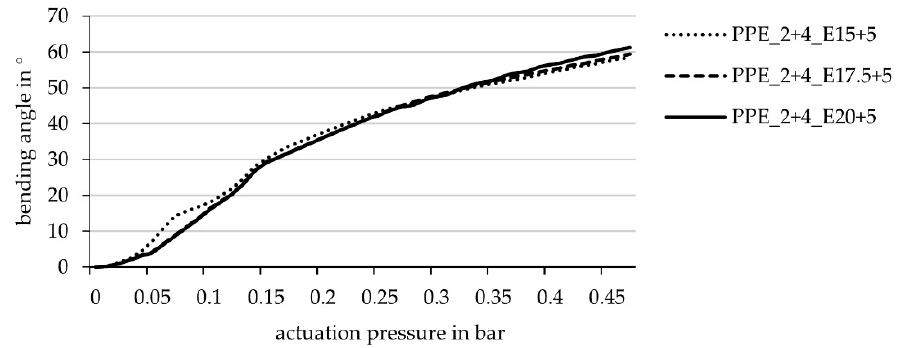
Figure 12. Achievable bending angle (simulation) in relation to the actuation pressure for laminate set-ups with different widths of the elastomeric layers enclosing the cushion chamber (width 10 cm): 15 + 5 cm, 17.5 + 5 cm, 20 + 5 cm (elastomer layer on the side with lower stiffness 5 cm wider than on the side with higher stiffness, cf. Figure 11).